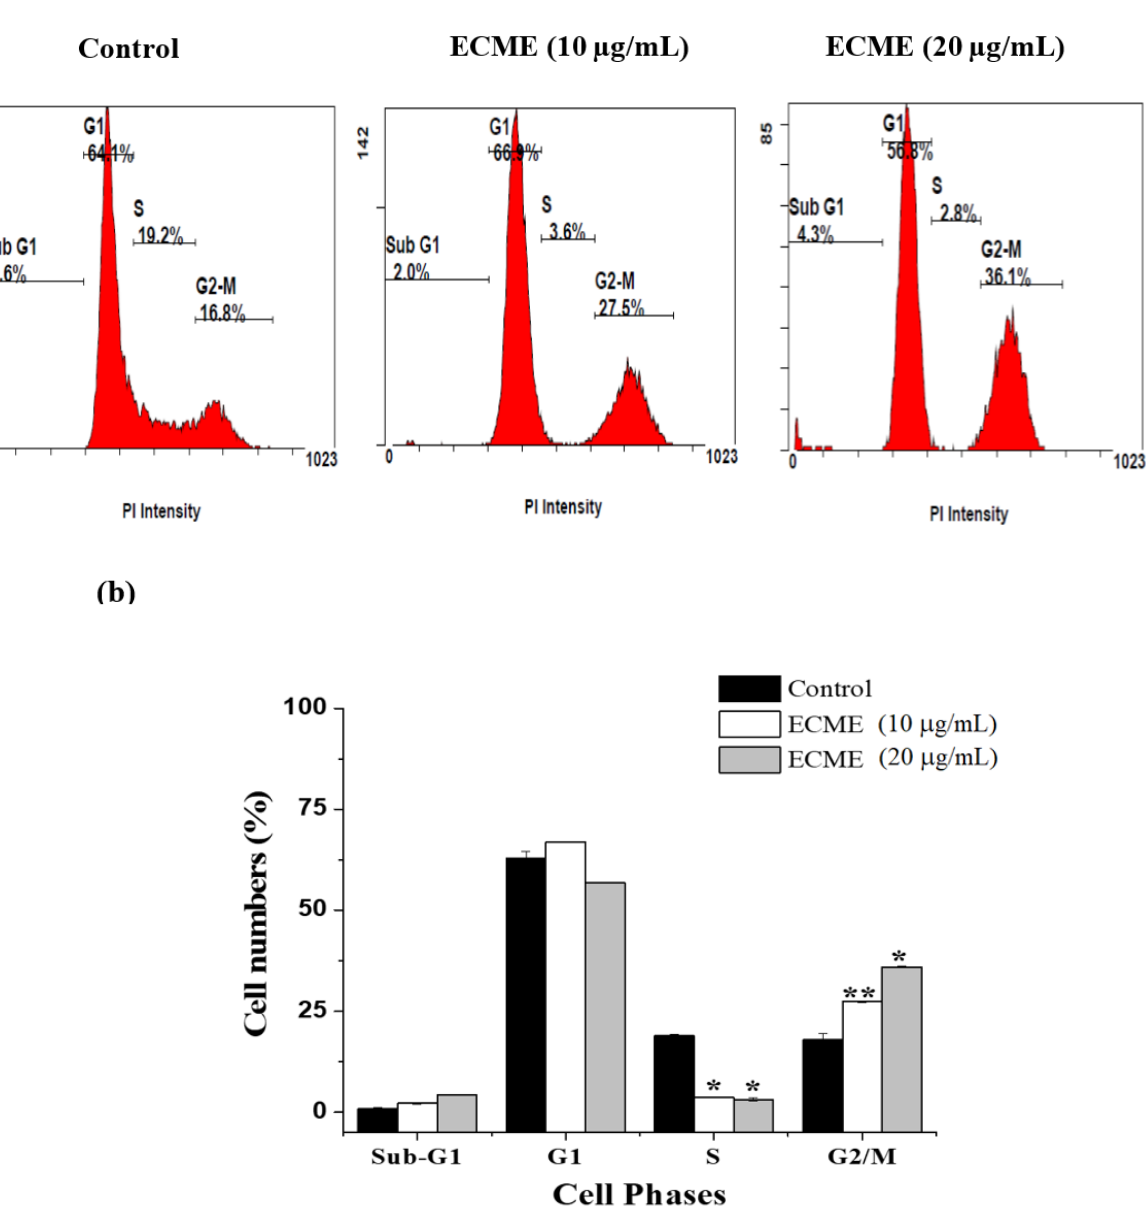
Figure 3. ECME induces G2/M phase cell cycle arrest in A549 cells. ( a ) The histogram shows the distribution of cell phases after treatment with corresponding IC 50 and its half concentrations (20 and 10 µg/mL) of ECME. ( b ) The values indicate the percentage of cells in the indicated phases of the cell cycle. Significant differences from the control are indicated by * p < 0.05; ** p < 0.01.